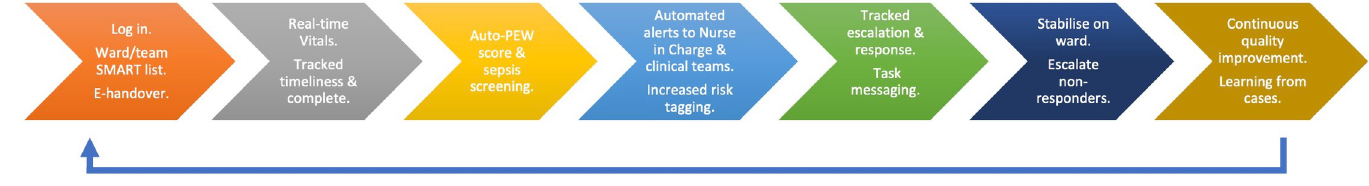
Fig 1. DETECT surveillance